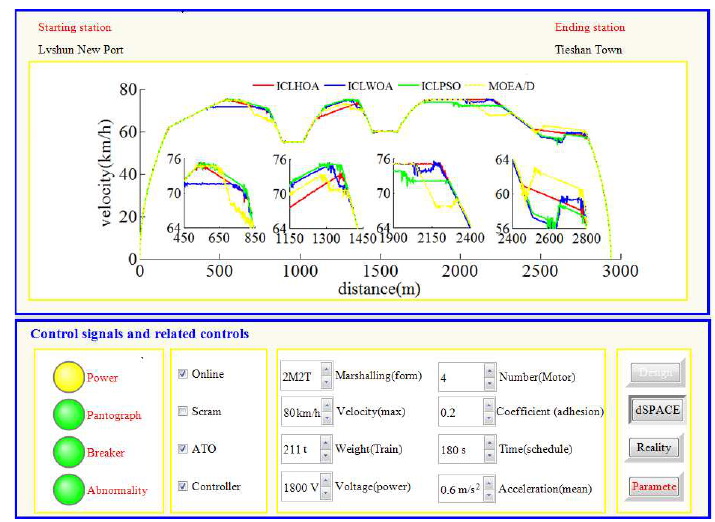
Figure 27. The actual velocity fuzzy PID tracking trajectory profile obtained by different algorithms in RCL-HILS (peak time